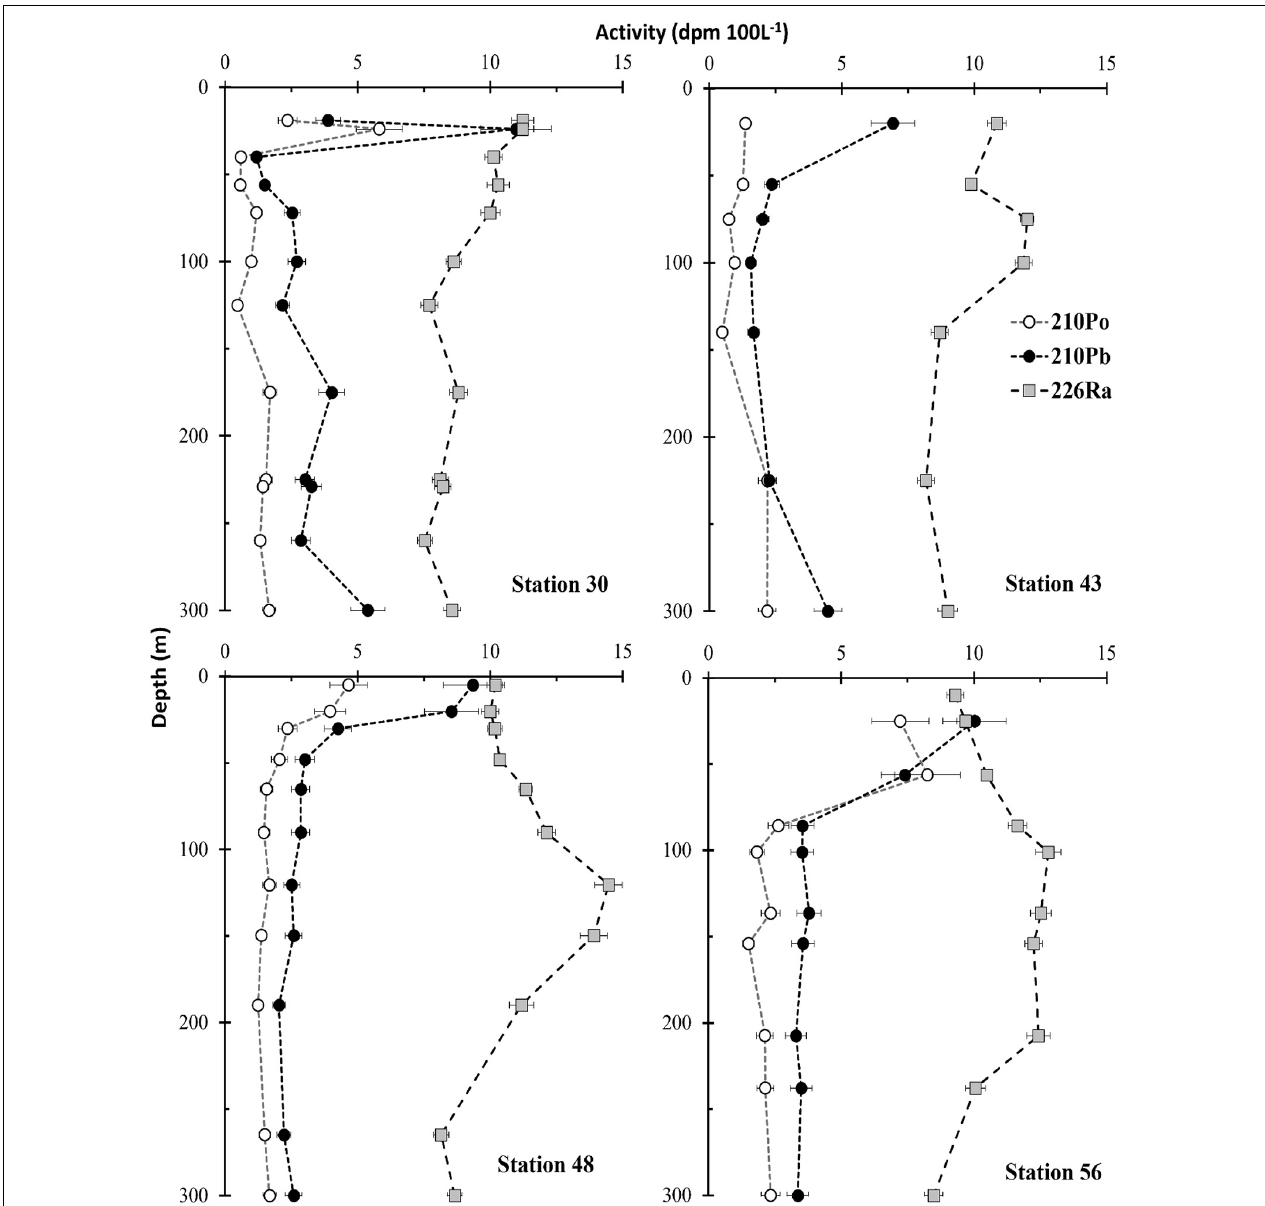
FIGURE 4 | The water column profiles of total 210 Po (open circle), 210 Pb (filled circle), and 226 Ra (filled square) at each station.